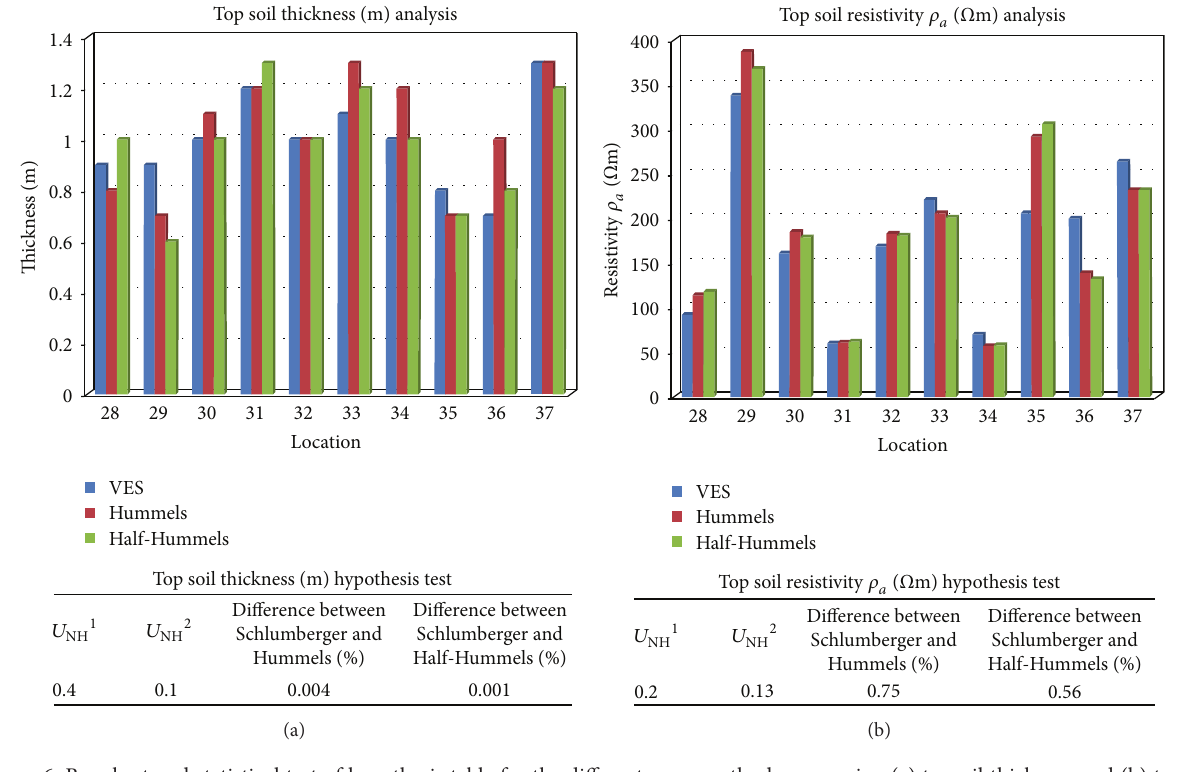
Figure 6: Bar chart and statistical test of hypothesis table for the different array methods comparing (a) topsoil thickness and (b) topsoil resistivity, for locations on quartz schist.